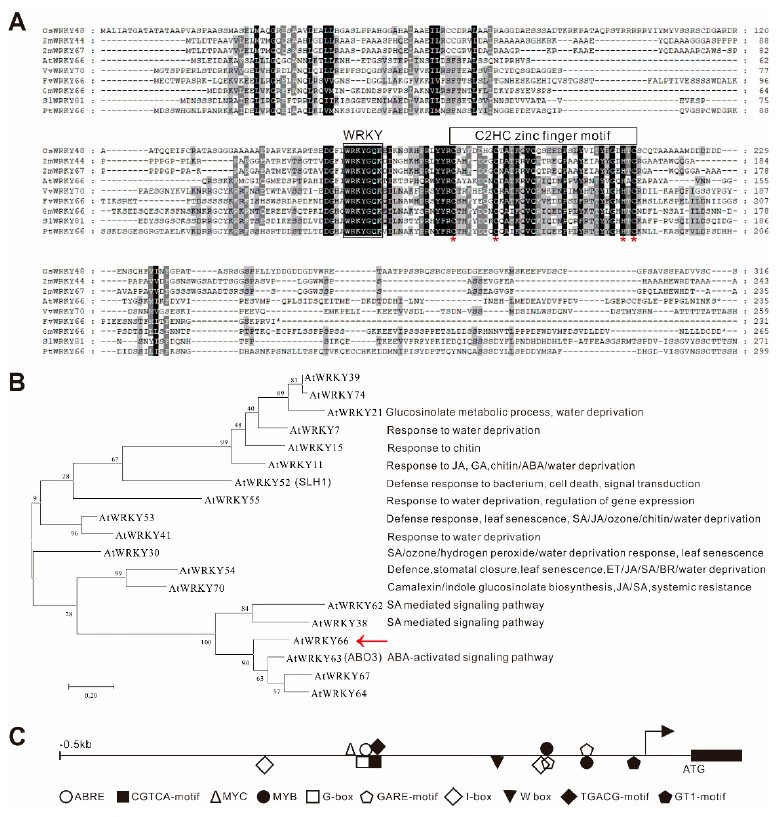
Figure 2. Characterization of the AtWRKY66 protein and gene. ( A ) . Multiple sequence alignment of AtWRKY66 with its homologs from Oryza sativa (Os05g0478400), Zea mays (Zm00001eb368850, Zm00001eb149550), Vitis vinifera (GSVIVG01032661001), Solanum lycopersicum (Solyc09g015770.3), Glycine max (Glyma.16G219800), Fragaria vesca (FvH4_6g09740) and Populus trichocarpa (Po- tri.016G137900). Identical and similar amino acids were shaded in black and light gray, respectively. The conserved WRKY motif and C2HC-type zinc-finger motif (C-X 7 -C-X 23 -H-X 1 -C) were marked by boxes and the residues of functional or structural importance were indicated by stars. ( B ). Phyloge- netic analysis of AtWRKY66 and WRKY proteins from Arabidopsis . IQ-TREE software with the max- imum-likelihood (ML) method (2000 bootstrap repeats) was used to reconstruct the phylogenetic tree. Protein sequences used for the phylogenetic analysis were shown in Supplementary Table S1. Reported names and functions in the stress response of the known stress-responsive WRKY genes were given in parentheses in the tree and listed at right of the tree, respectively. The red arrow indicated the focus of this study. ( C ). Distribution of cis -elements in the promoter region of the AtWRKY66